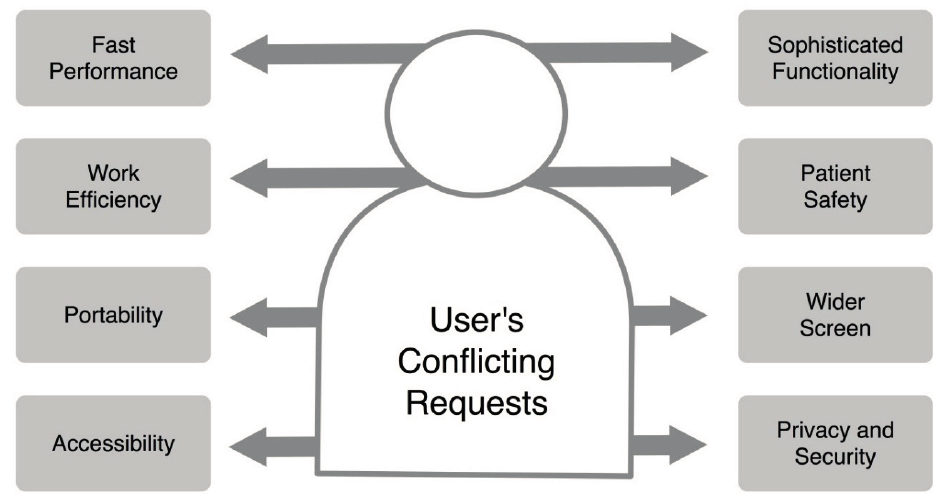
Figure 10. The conflicting requests of healthcare app users. Arrows indicate the trade-off